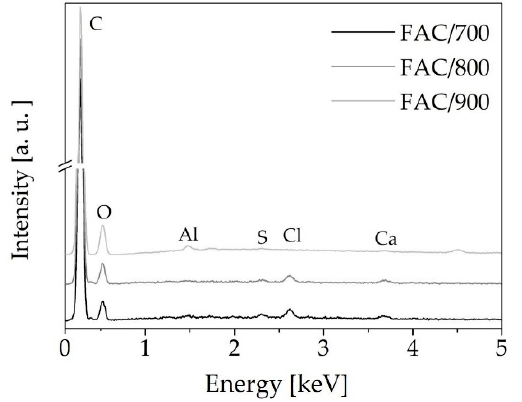
Figure 1. EDX analysis of the activated carbons derived from common polypody leaves at temperatures of 700, 800, and 900 °C.